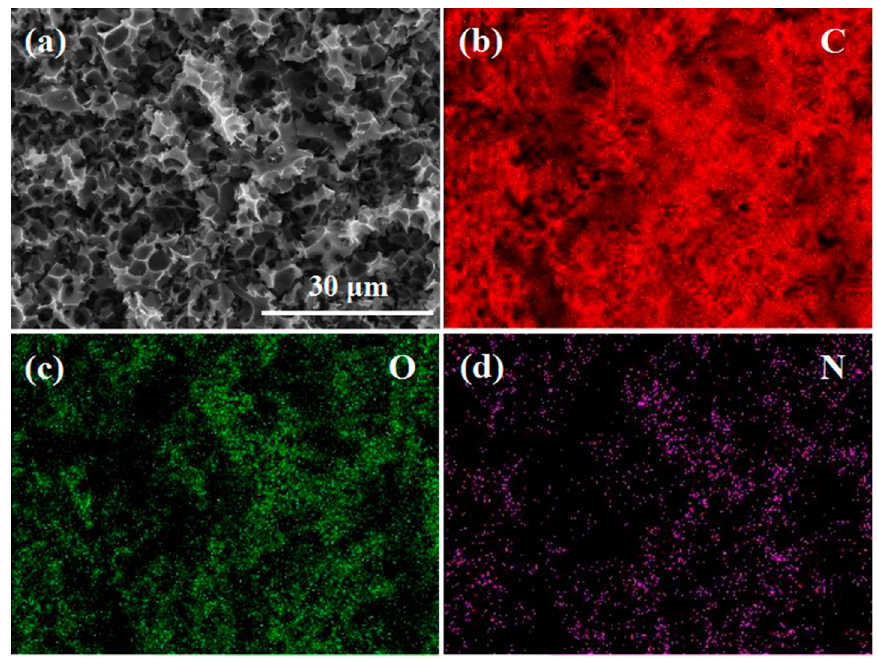
Figure 6. ( a ) SEM image of a-CSH-700, and elemental mapping images of ( b ) C, ( c ) O, and ( d ) N.